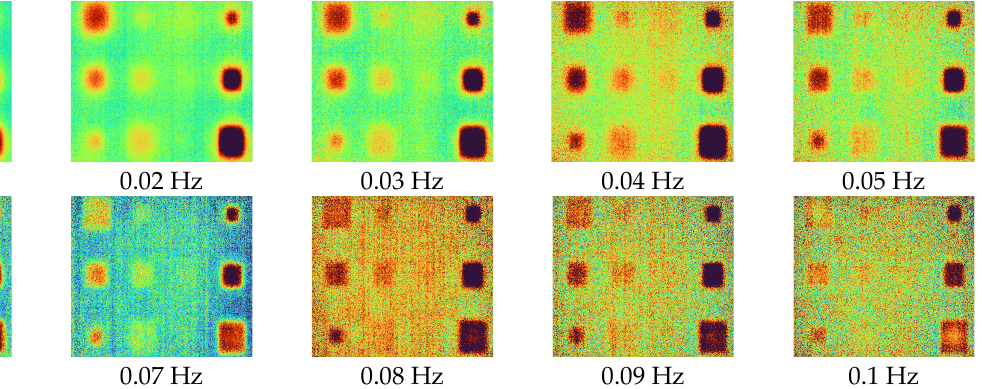
Figure 7. Phase images for excitation frequencies range from 0.01 to 0.1 Hz.